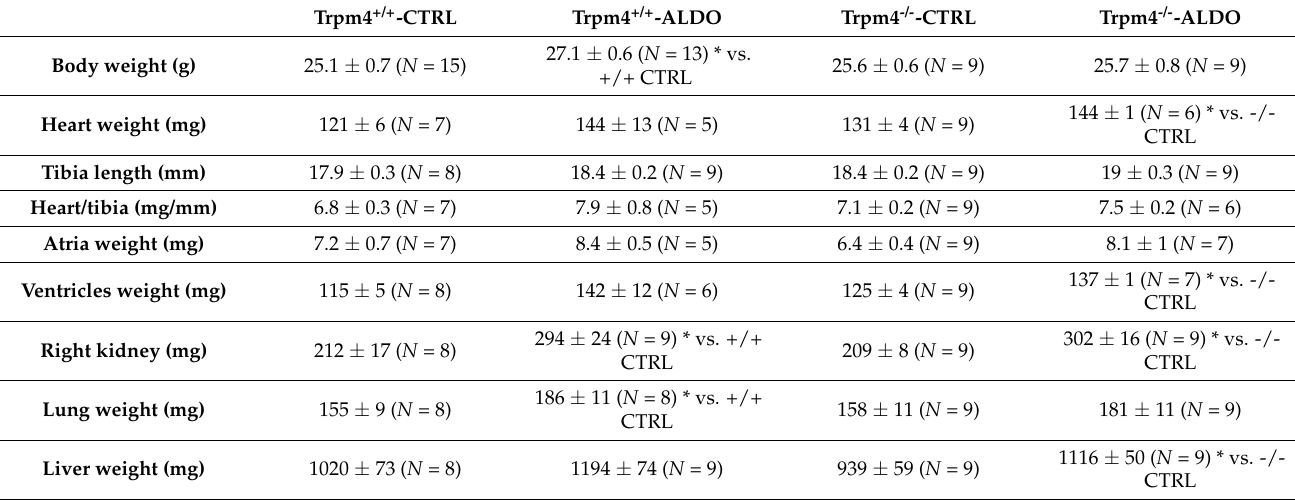
Figure 1. Left atrial structural remodeling after aldosterone + salt treatment. ( A ) Example of transthoracic echocardiography for Trpm4 +/+ and Trpm4 -/- without (CTRL) or with (AL+S) 28 days aldosterone treatment on anesthetized 3-month-old female mice. The CTRL group corresponds to the control group with only the left nephrectomy. The AL + S group corresponds to the group with the left nephrectomy + aldosterone treatment and rich NaCl diet. For each group, the left panel indicates a representative B-mode image showing aorta (ao) and left atrium (LA) while the right panel shows the corresponding M-mode (cursor line indicated in the left panel). ( B ) Mean left atrial diameter according to the echography measurements before (D0) and after 28 days (D28) of treatment without (white) or with (black) aldosterone. Aldosterone produces a significant dilatation after 28 days. The numbers in the bars correspond to the number of animals. Picro Sirius red staining was used to search for fibrosis in left atrium slices at D28 for at least eight animals per group. Statistical significance between groups are indicated by *. Table 2. Morphological mouse